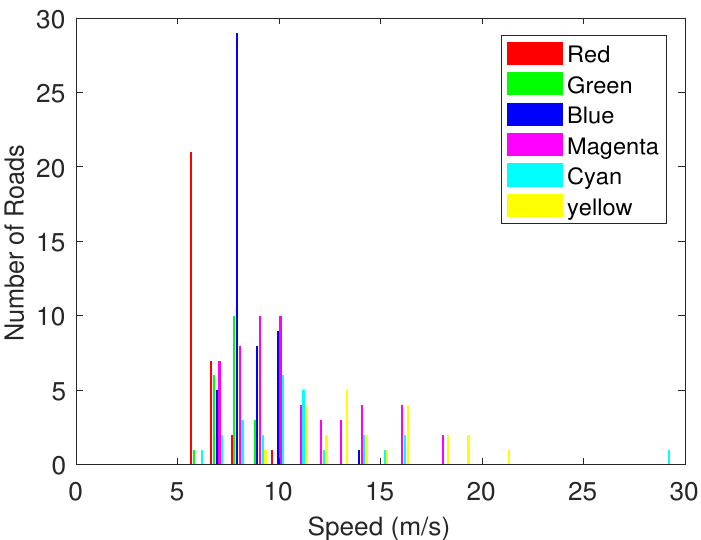
Figure 13. Histogram of link speeds for the time period = 6 in the case of the modularity.